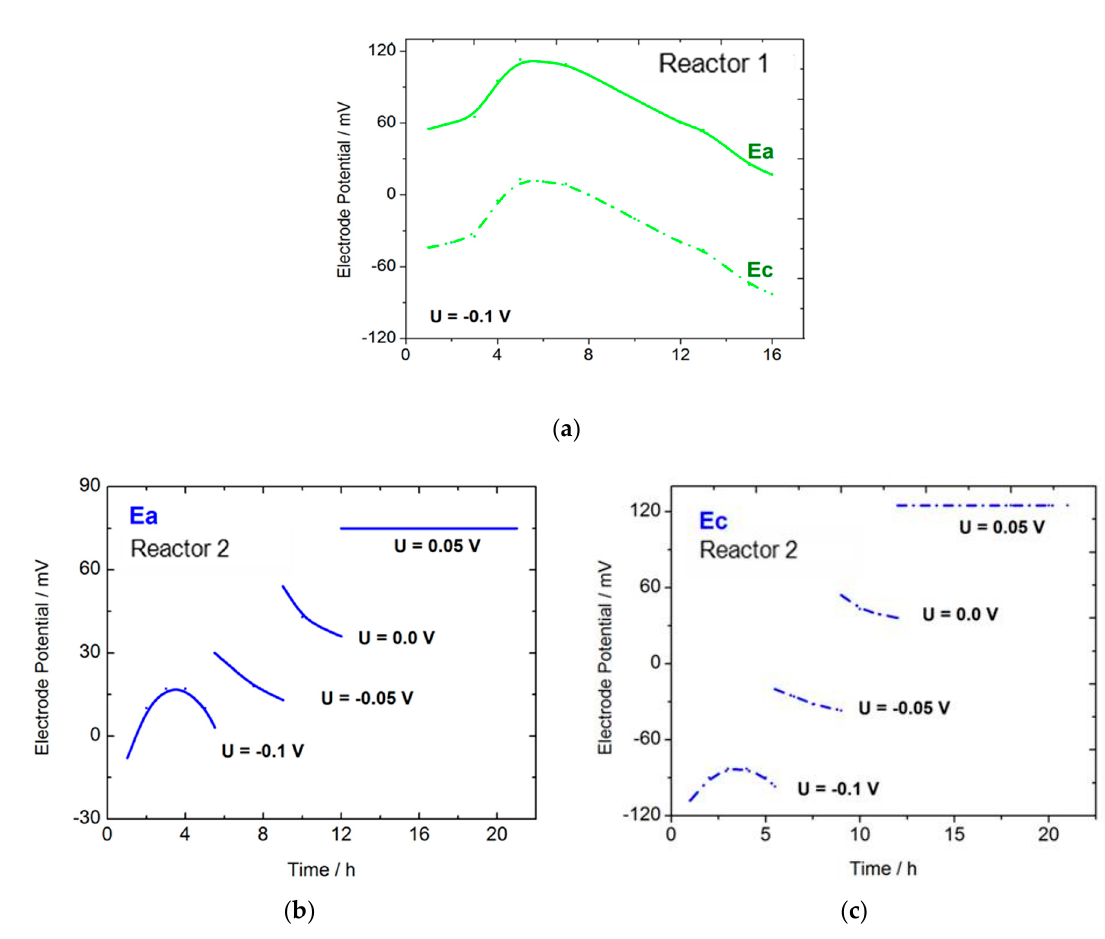
Figure 6. (a ) Change of anode and cathode electrode potentials during reactors operation for the reactor 1; ( b ) change of anode electrode potential and ( c ) changed of cathode electrode potential during the reactor operation for the reactor 2, conditions presented in Table 3. Table 3. NMR results for electroenzymatic reactors operated at two di ff erent conditions of cell potential and time, 5 mL min − 1 (Figure